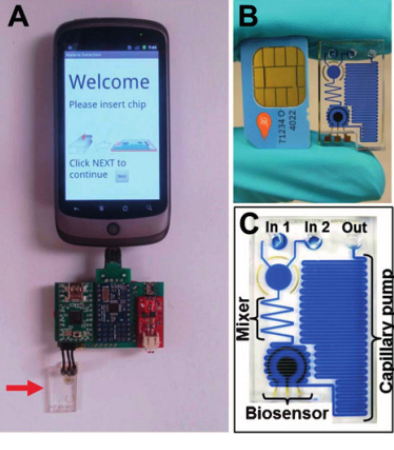
Figure 19. ( A ) Photograph of the assembled prototype device. ( B ) Photograph of the chip and a mobile phone SIM card for comparison. ( C ) An enlarged image of the chip with labeled components. The channels are filled with dye for improved visualization of the fluidic network (Reproduced with permission from